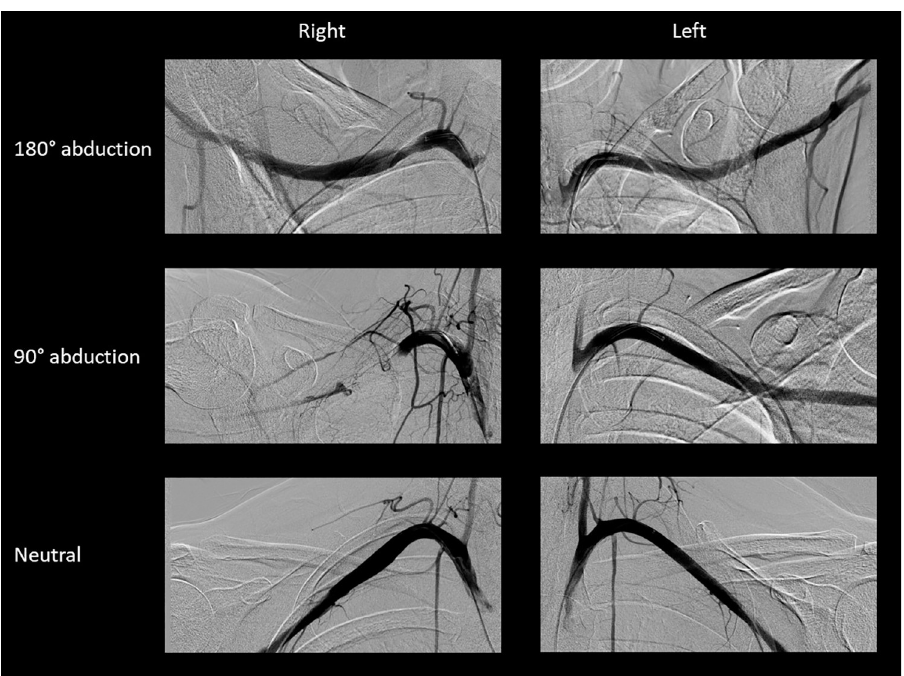
Fig 6. Angiography of the subclavian artery in TOS. Angiography of the subclavian artery of a patient with arterial TOS on the right side. Note the complete occlusion of the right artery when the arm is in 90˚ abduction, and the stenosis with poststenotic dilation when in 180˚ abduction.